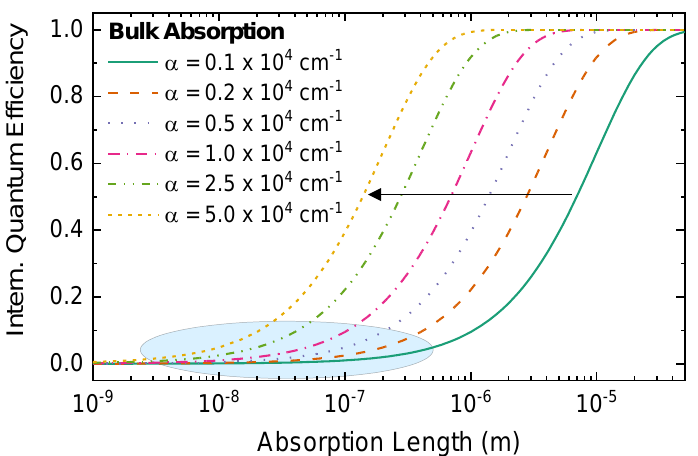
Figure 6. Internal quantum efficiency as a function of absorption length for increasing absorption coefficients from α = 0.1 × 10 4 cm − 1 to α = 5 × 10 4 cm − 1 . The grey-shaded region coefficients from 𝛼 = 0.1 × 10 4 cm − 1 to 𝛼 = 5 × 10 4 cm − 1 . The grey-shaded region represents